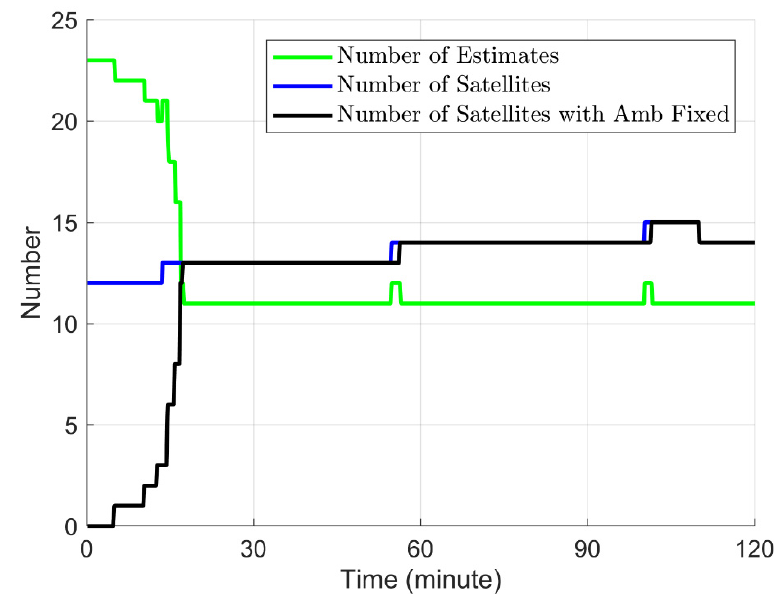
Figure 5. The change of the number of states estimated in the EKF (green), satellites (blue), and satellites with ambiguity fixed (black).